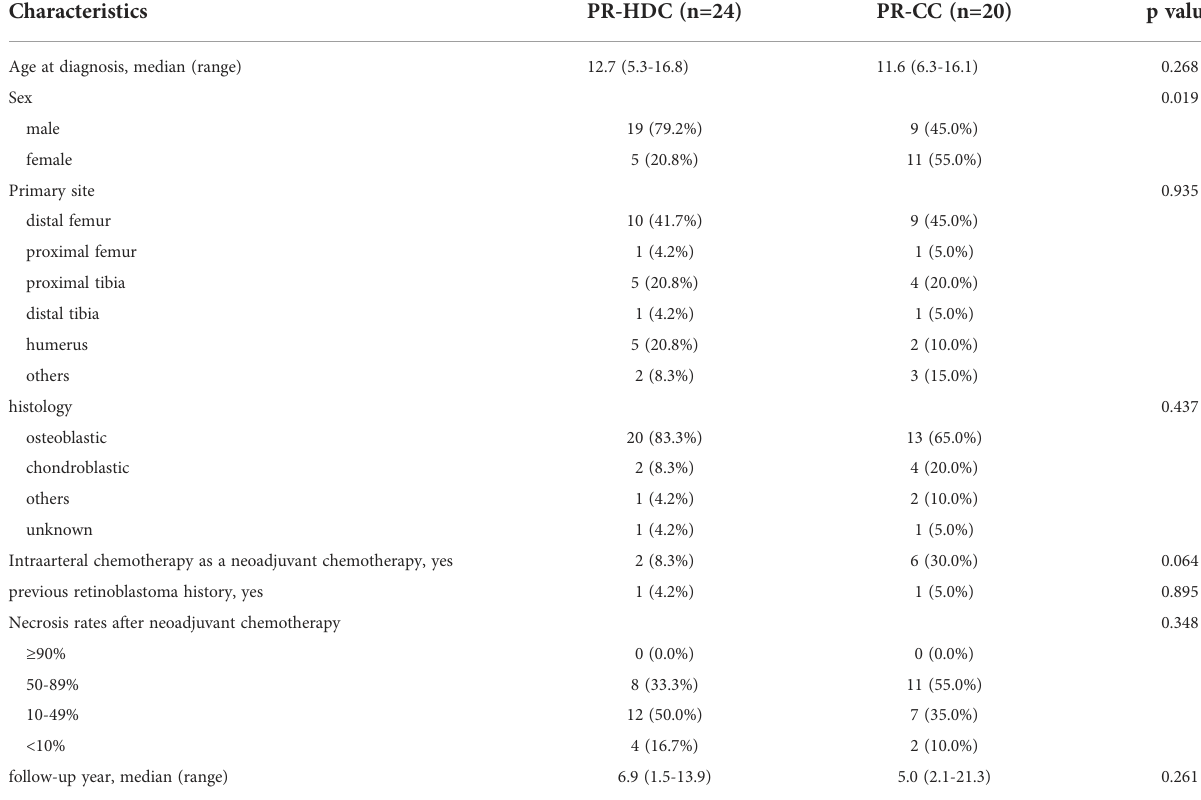
TABLE 2 Comparison of characteristics of the poor response